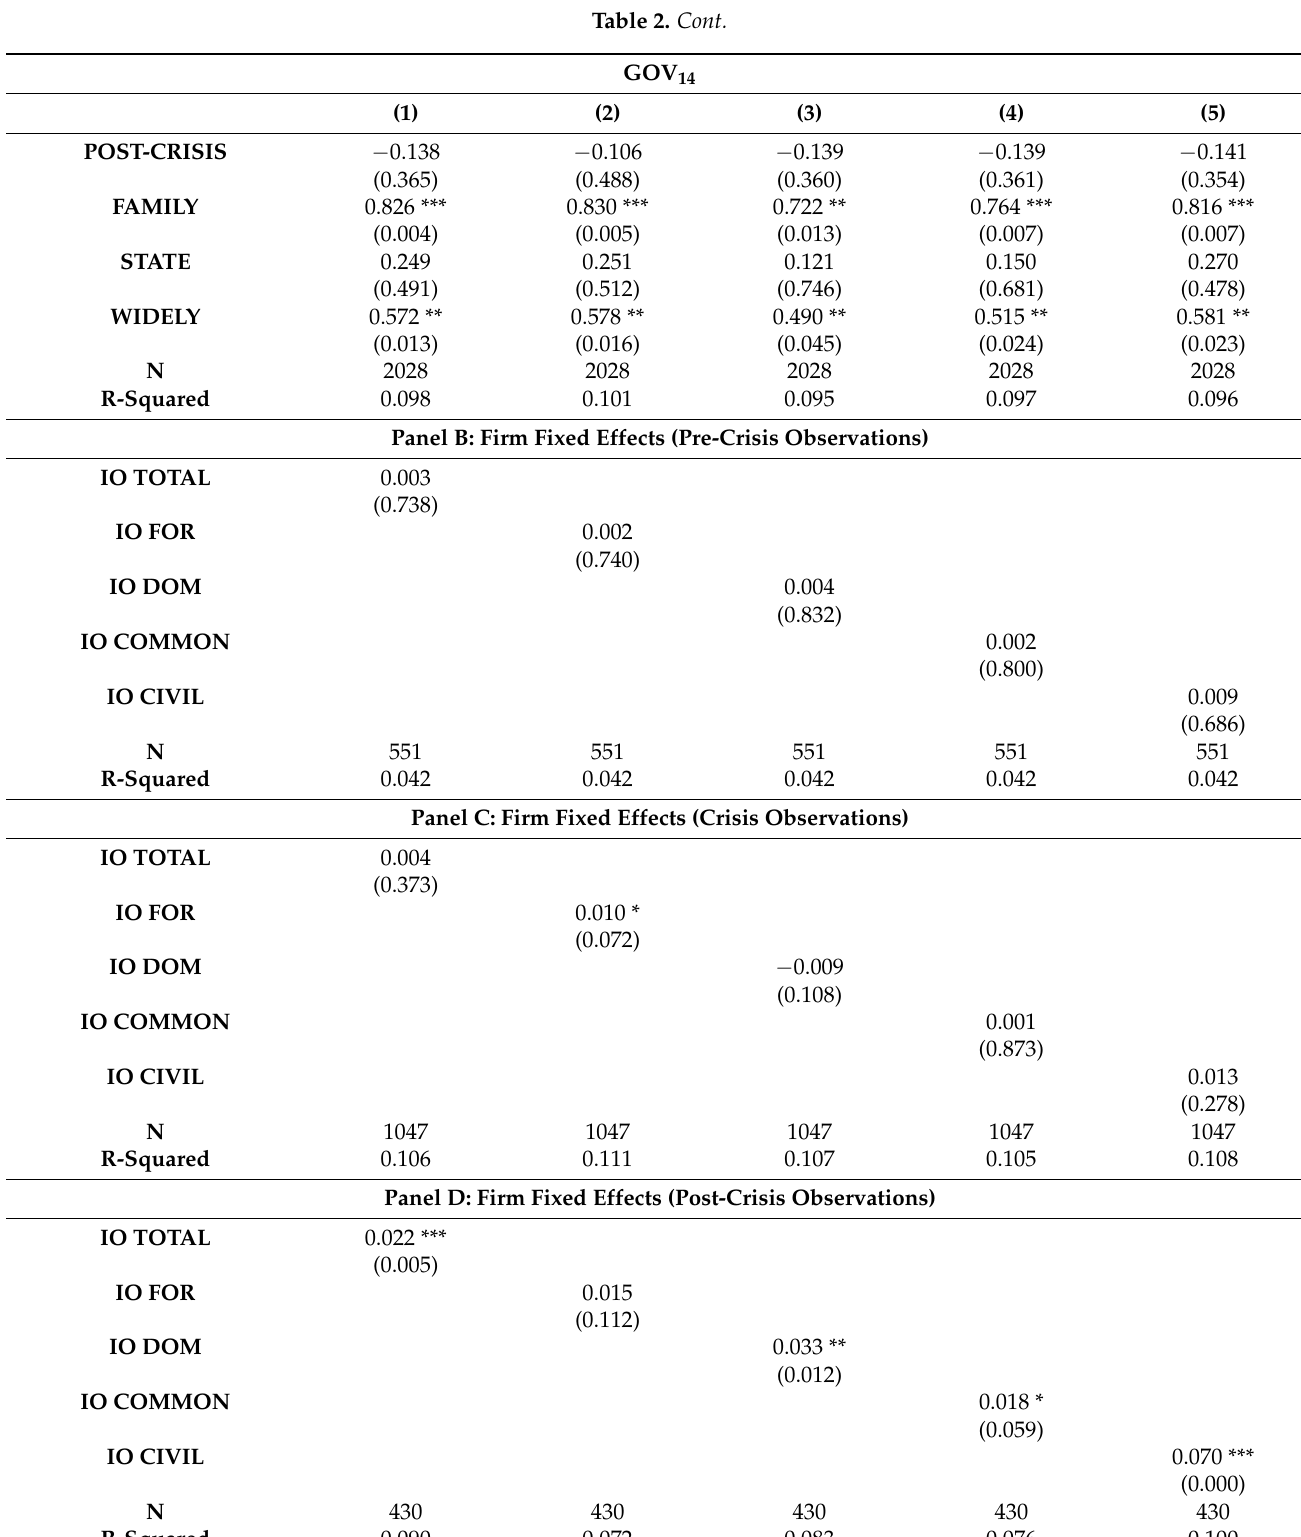
Panel D: Firm Fixed Effects (Post-Crisis